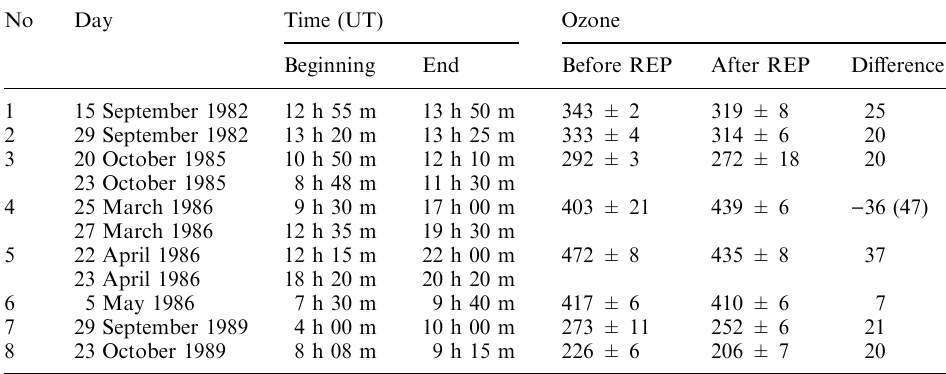
Table 1. List of REP events and changes of total ozone in